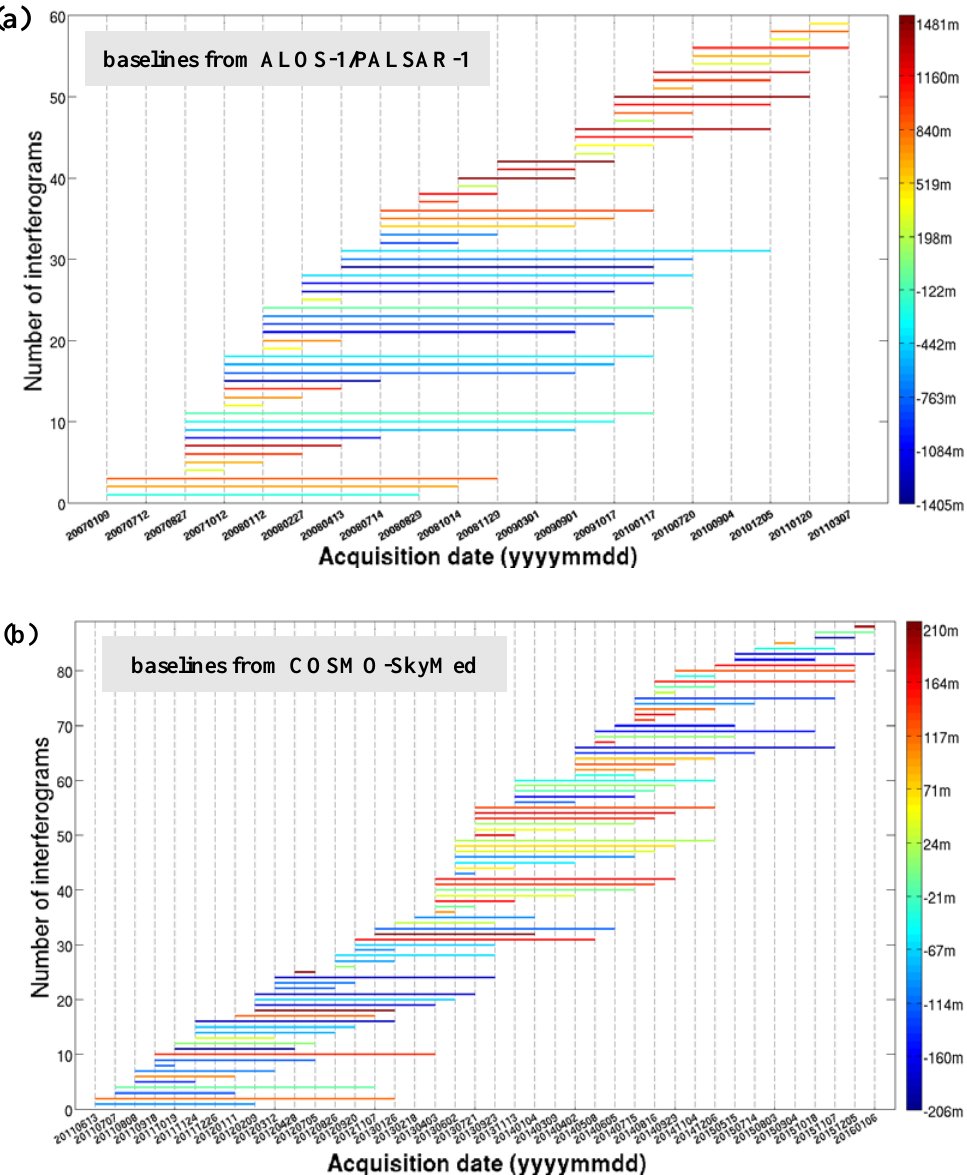
Figure 4. The distribution of the temporal and spatial baselines from ( a ) Advanced Land Observation Satellite (ALOS-1) and ( b ) Constellation of Small Satellites for Mediterranean basin Observation (COSMO-SkyMed) in this study.